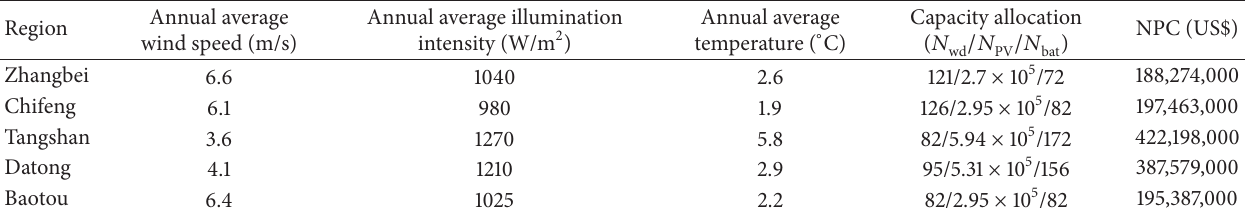
Table 8: Comparative analysis of allocations in different